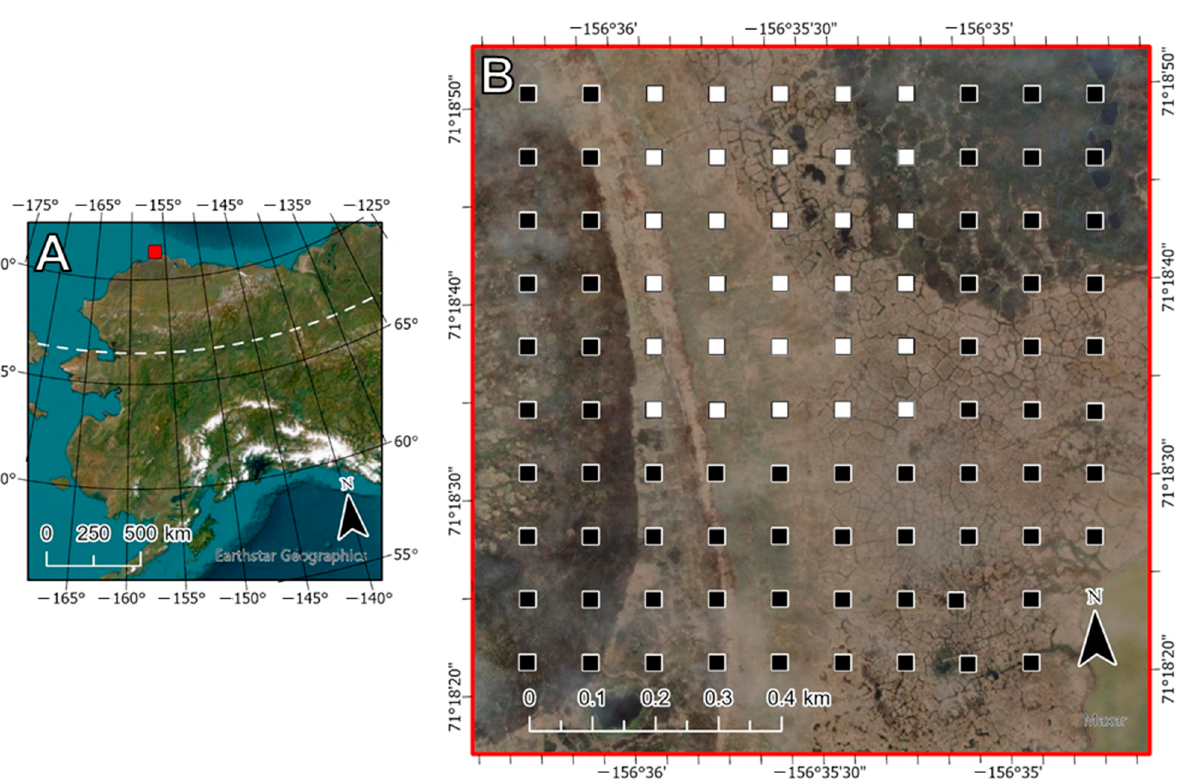
Figure 1. Map of the research site. ( A ) The site is stationed above the Arctic Circle (denoted by a white dashed line) on the Barrow Peninsula near the city of Utqia ġ vik, Alaska. ( B ) The 30 vegetation plots in this analysis are represented by white squares. These plots are part of a larger collection of 98 plots (denoted by black squares), which are evenly distributed at a 100-m interval across the Arctic System Science (ARCSS) grid.